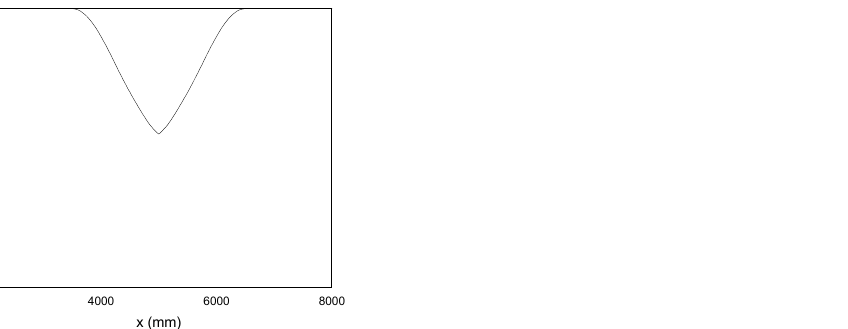
Figure 2. Examples of profile for running the simulation (dipped joint of 2.5 mm and short settlement of 20 mm).